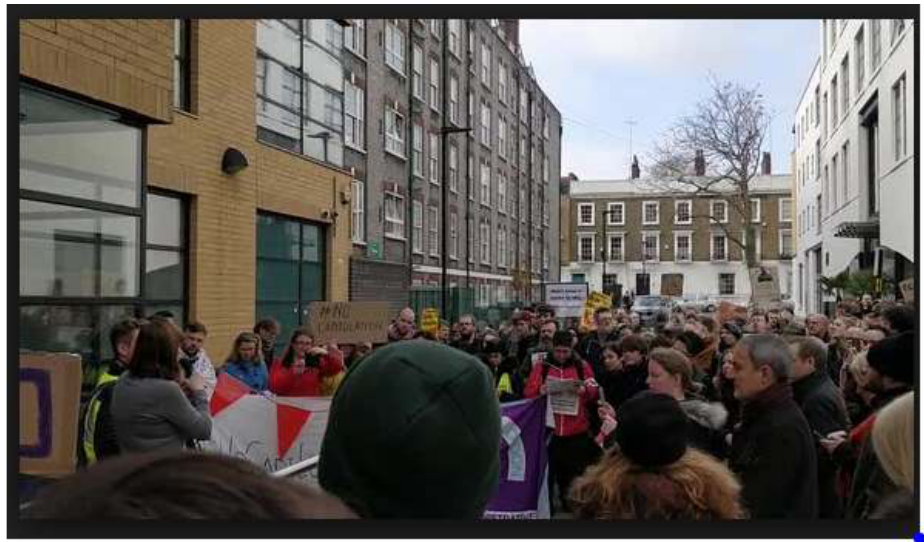
Source: Reelnews, 2018.